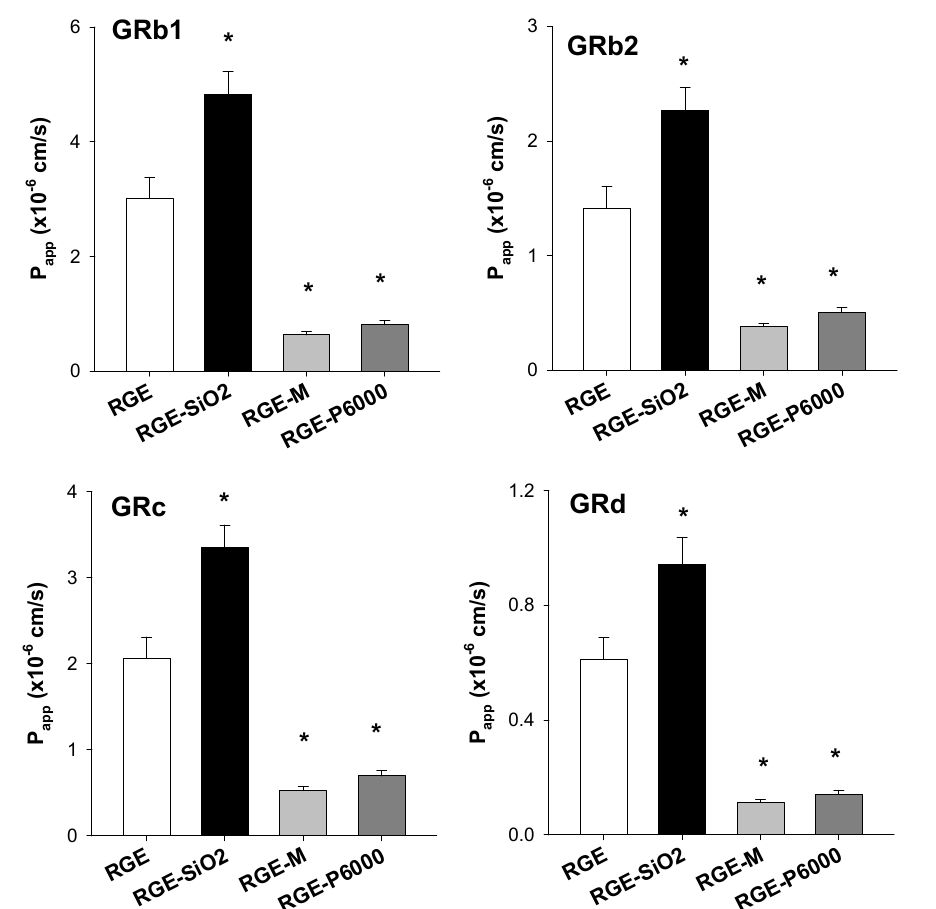
Figure 7. Intestinal permeability (P app ) of ginsenoside Rb1 (GRb1), GRb2, GRc, and GRd from the solid dispersions of red ginseng extract (RGE), RGE-SiO 2 , RGE-M, and RGE-P6000 was measured in the rat jejunum using the Ussing system. Data represent the mean ± standard deviation ( n = 3). * p < 0.05, statistically significant compared with the RGE group by the Student t -test. Table 3. Pharmacokinetic parameters of ginsenoside GRb1, GRb2, GRc, and GRd after single oral administration of RGE (375 mg/kg) and solid dispersion formulation of RGE-SiO 2 (375 mg/kg as RGE) in rats. Formulation